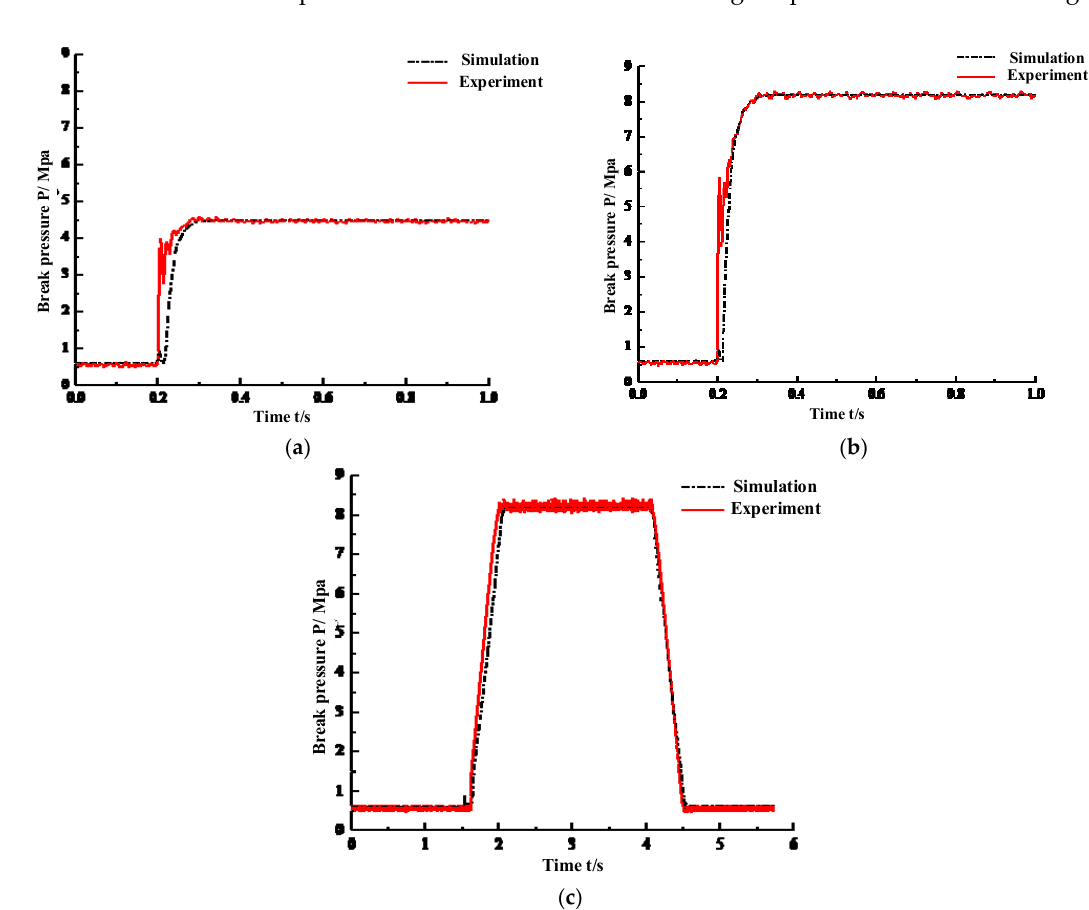
Figure 10. Experimental test results of TSBPSV. ( a ) 20 mA step current input. ( b ) 40 mA step current input. ( c ) 40 mA ramp current input.